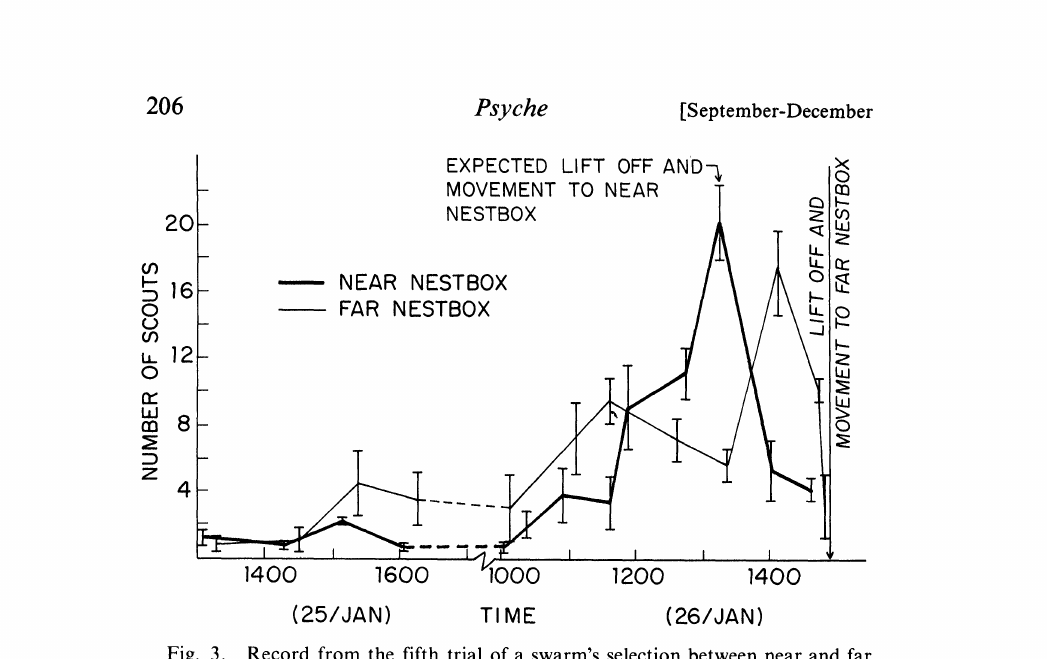
Fig. 3. Record from the fifth trial of a swarm’s selection between near and far nestboxes, as monitored by counting the scouts visible at each nestbox. Vertical bars denote plus and minus one standard deviation for 10 counts at 15 second